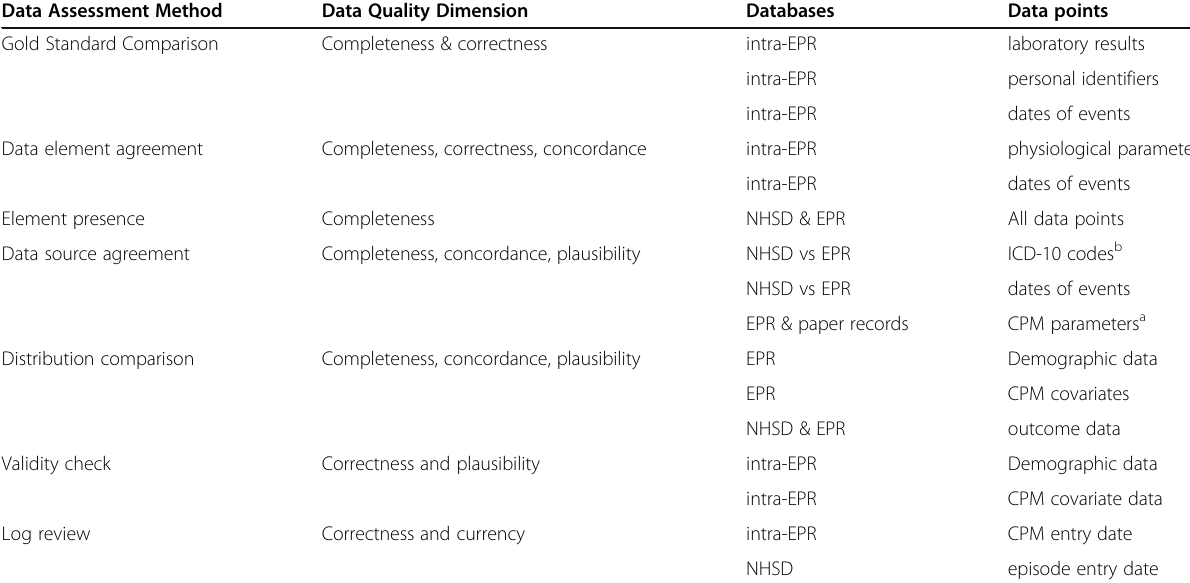
Table 1 Data validation procedures adapted from Weiskopf et al